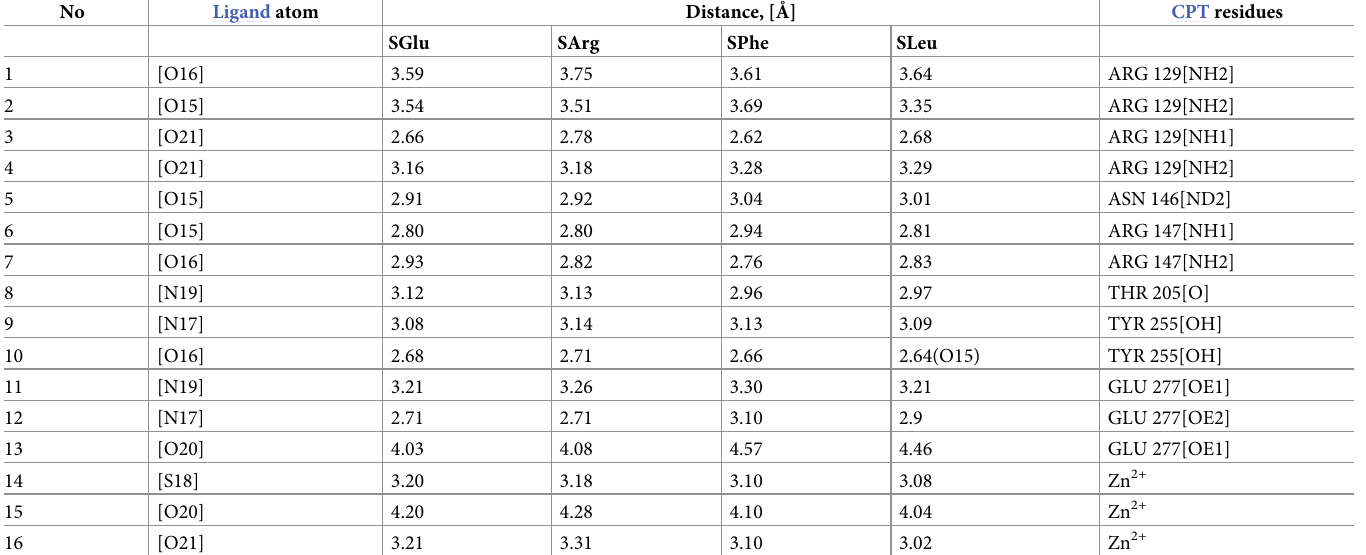
Table 3. Distances between CPT catalytic subsite residues and N-sulfamoyl ligands.